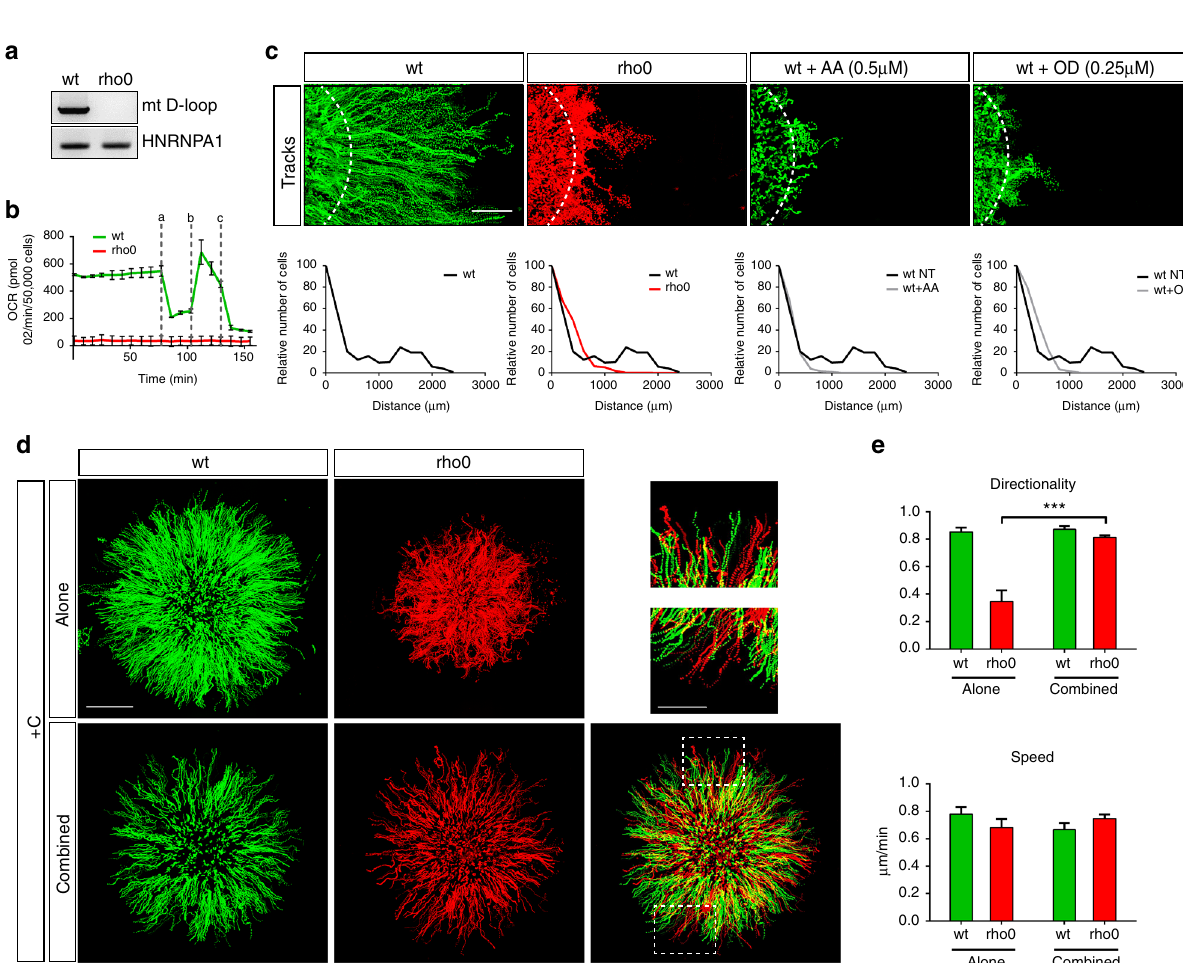
Fig. 2 Mitochondria self-generate hypoxia but are nonessential for directed migration towards oxygen. a PCR ampli fi cation of mtDNA D-loop region and hnRNPA1 nuclear DNA in wt MCF10A and rho0 cells demonstrating the effective depletion of mtDNA from rho0 cells. b Oxygen consumption rate (OCR) of wt and rho0 cells before and following addition of ( a ) oligomycin D (0.5 µ M), ( b ) FCCP (1 µ M), ( c ) antimycin A 0.5 µ M + rotenone (0.5 µ M) (mean ± SD). This experiment demonstrates that rho0 cells are indeed unable to respire. c Tracking and redistribution of rho0 (red) and wt (green) cells set under con fi nement and treated or not with antimycin A (AA) or oligomycin D (OD) demonstrate that hypoxia generation is required for directed migration under con fi nement. Top panels: cell trajectories. White dotted-lines indicate the border of the cell cluster at 0 h. Bottom panels: relative distribution of MCF10A cells at the edge of the cluster at 0 h and 48 h post-con fi nement. Scale bar, 500 µ m. d Tracking of con fi ned rho0 (red) and wt cells (green) either alone or combined (1:1 ratio) for 24 h. Upper right: magni fi cation of the framed regions. This experiment demonstrates that rho0 cells that do not respire are still capable of aerotactic migration provided that they are located within the oxygen gradient generated by wt cells. Scale bars; 1 mm (500 µ m for magni fi cation panels). e Mean values of directionality and speed from ( d ) (mean ± SD; n = 3 independent experiments). *** P < 0.001 by two-tailed Student ’ s t -test. + C